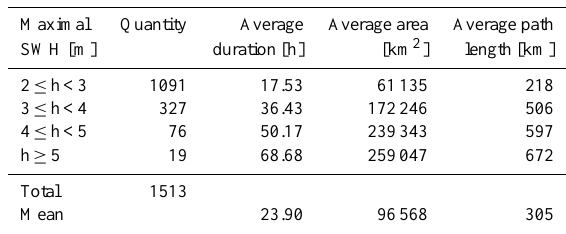
Figure 26. Interannual variability of the NAO index and storm events per year, its linear trend ( − 0.02stormsyear − 1 ), and 95% (dark grey) and 99% (light grey) confidence intervals. Table 2. Quantity and average duration, area and path length of